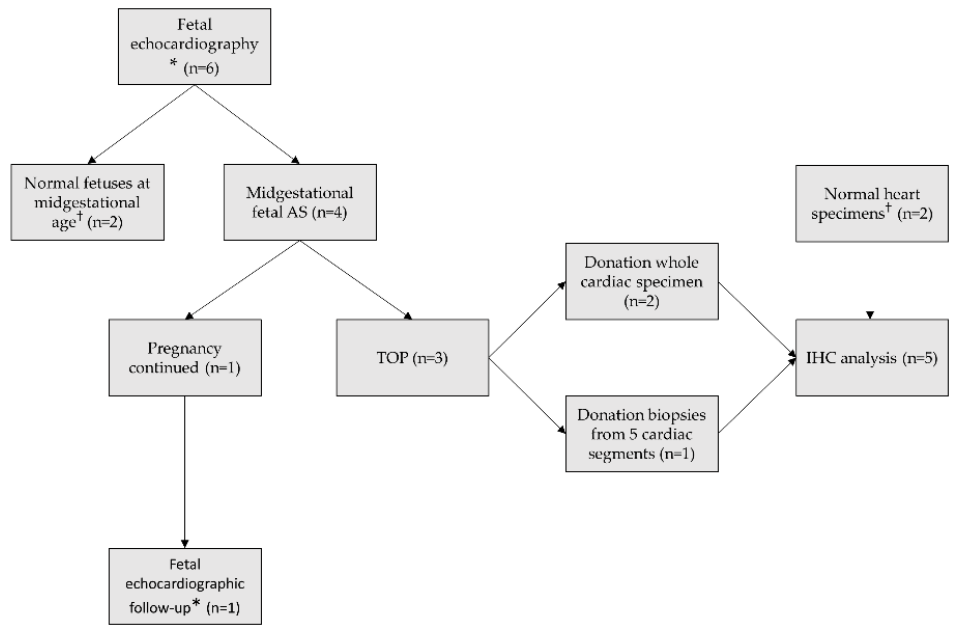
Figure 1. Overview flowchart of methods. * Offline speckle tracking analysis included; † Served as control data; AS, aortic stenosis; TOP, termination of pregnancy; IHC immunohistochemical.